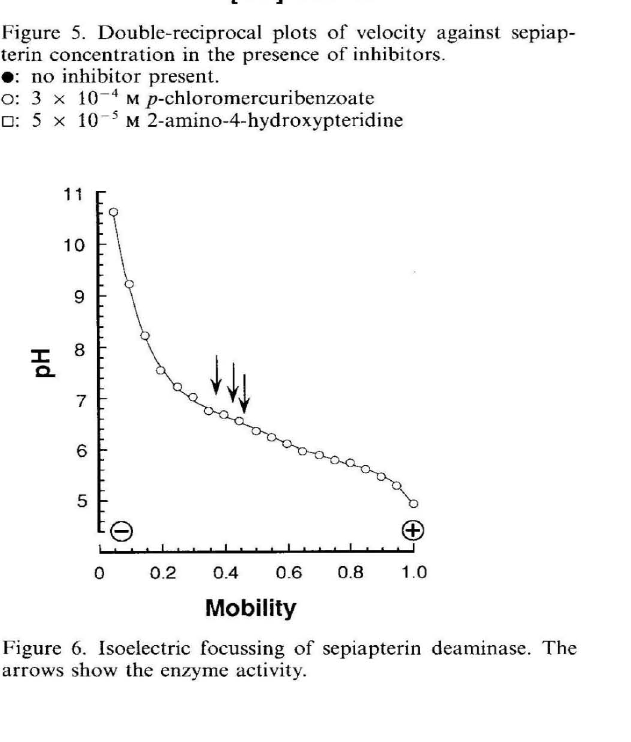
was washed twice with 0.25 M sucrose, pteridines were twice extracted by a glass homogenizer into the same volume of the same buffer described in enzyme ex traction. Because fraction C and D contained large amounts of uric acid, each 3 and 7 ml of 1 N NaOH were added respectively to the precipitates of the second extract for complete extraction of the com pound. Pteridines and uric acid contained in each fraction were assayed by HPLC. We found negligible amounts of pteridines in fraction B. As shown